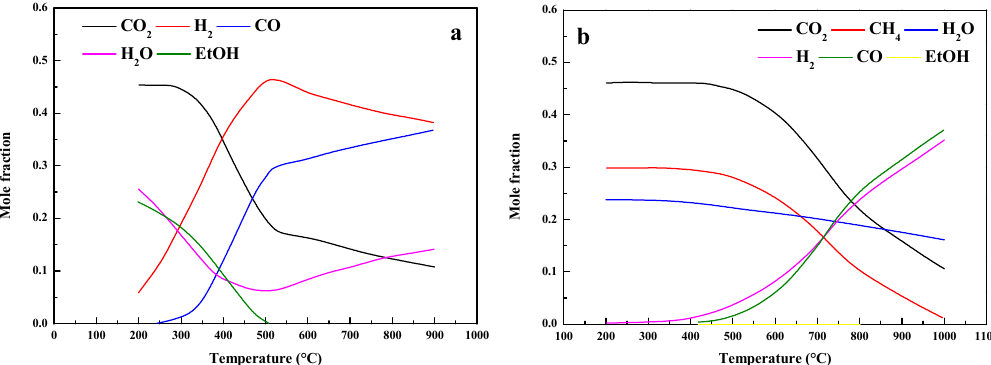
Figure 4. Equilibrium concentrations of mixture syngas: No CH 4 allowed ( a ) and CH 4 allowed ( b ; H 2 = 49%, CO = 26%, CO 2 = 21%, and H 2 O = 4%).